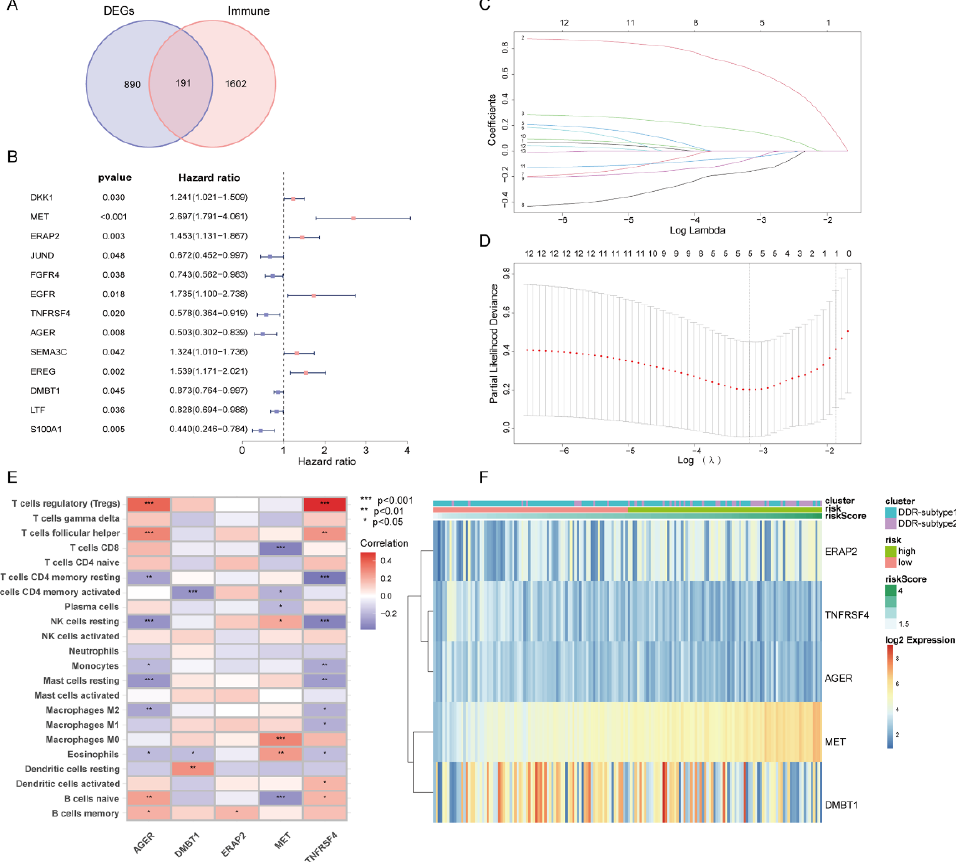
Figure 5. Generation of DDR- and immune-based signature. ( A ) Venn-diagram-described DDR-based DEGs ( n = 1081) were intersected with the immune genes ( n = 2483) and altogether 191 overlapping genes were screened. ( B ) Forest plot of univariate Cox regression analysis showed that 13 DEGs were associated with prognosis. ( C ) LASSO coefficient profiles. ( D ) Selection of the tuning parameter (lambda) in the LASSO model by 10-fold cross-validation based on minimum criteria for OS. ( E ) Heatmap of relationship between the 5-gene signature and immune infiltration. ( F ) Heatmap of 5-gene signature by unsupervised clustering. The DDR subtype, risk group and risk score as gene annotations were correlated.